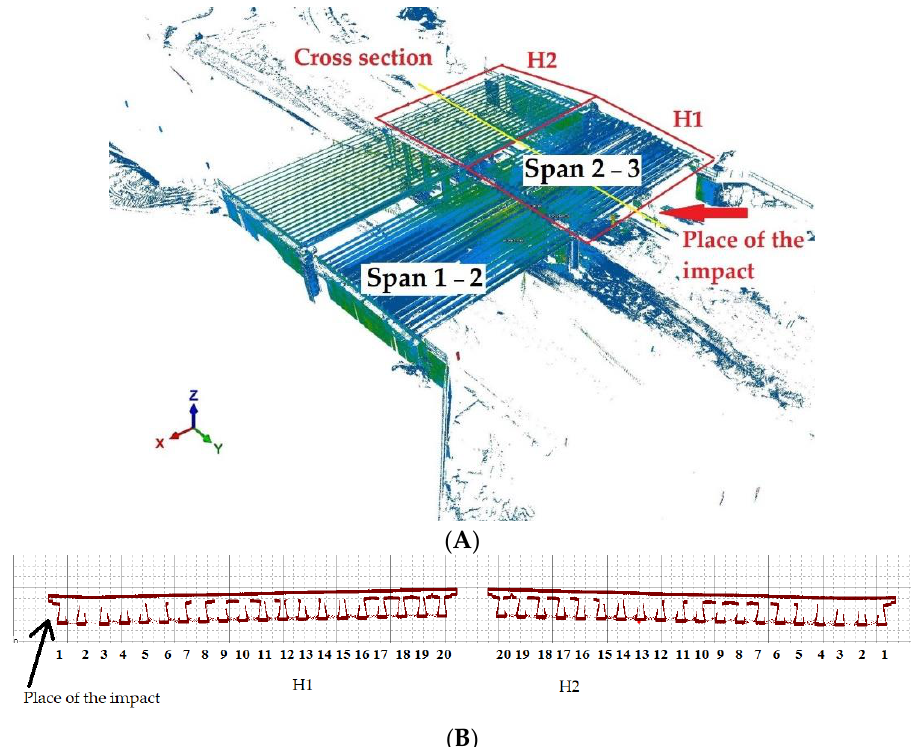
Figure 4. General view of the ( A ) obtained point cloud and ( B ) its cross-section.